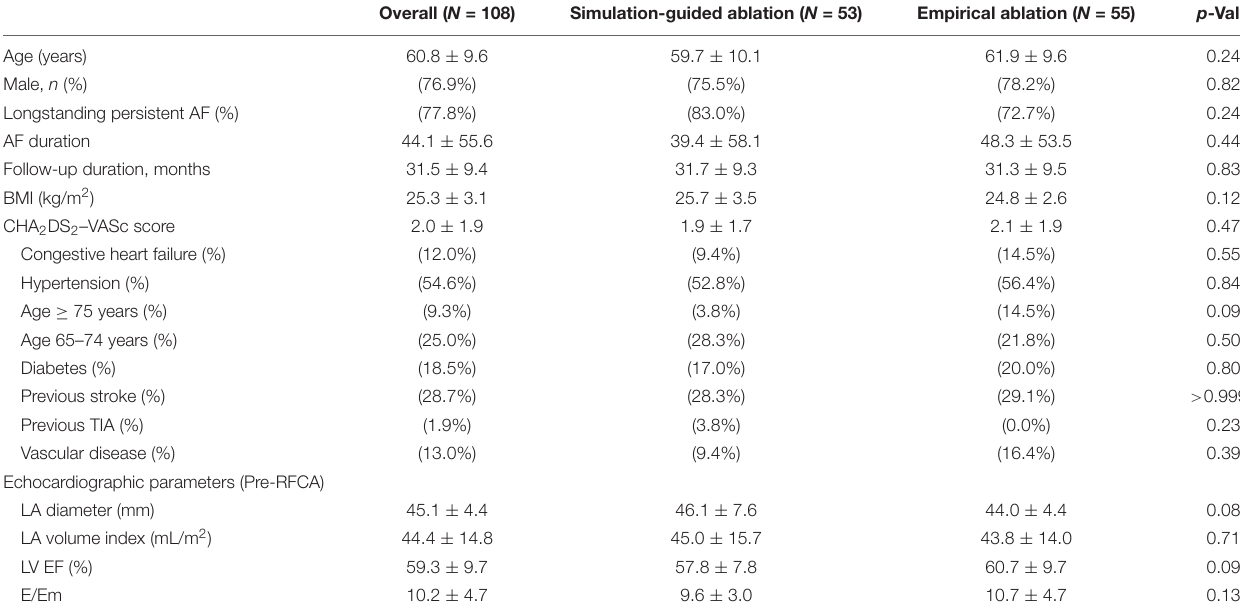
TABLE 1 | Baseline clinical characteristics.